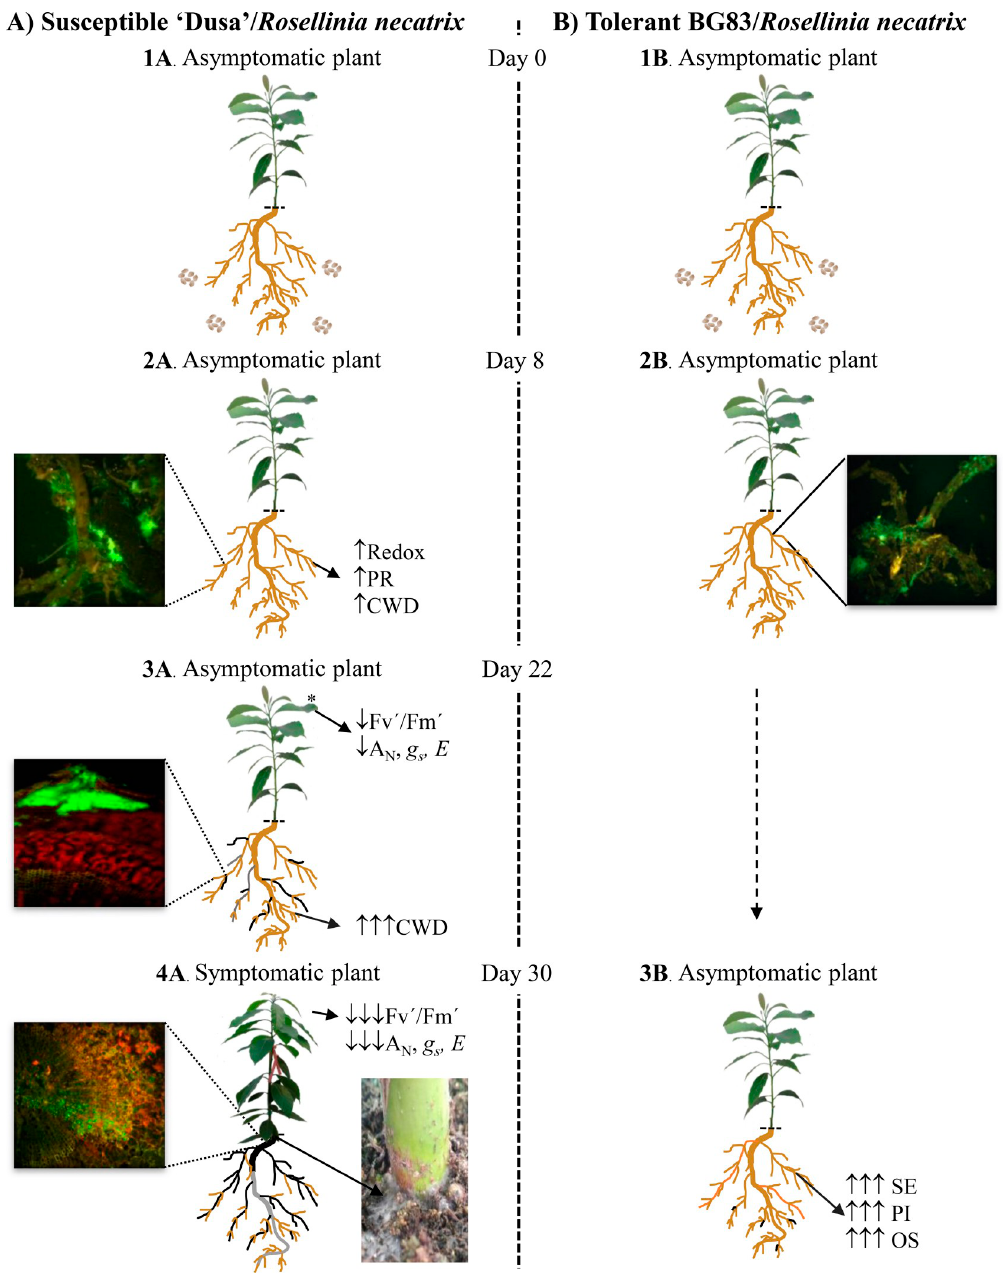
Fig 6. Comparative model of Rosellinia necatrix infection on susceptible ‘ Dusa ’ (A) and Tolerant BG83 genotypes (B) . 1A . Inoculation of asymptomatic ‘Dusa´plant with wheat grains infected with R . necatrix . 2A . 8 days post inoculation. Visualization of R . necatrix derivative strain CH53- gfp mycelia colonizing the root surface of avocado plantlets without aerial symptoms. The green fluorescent emitted from R . necatrix - gfp was visualized using a fluorescence microscope. Upregulation of genes mainly related to oxidoreduction activity (Redox), cell wall degradation (CWD) as well as potential genes involved in defence to P . cinnamomi (PR) was observed. 3A . 22 days post inoculation. The image shows a radial section of susceptible roots infected with R . necatrix - gfp ; penetration and proliferation of R . necatrix mycelia through the root cortex was observed by Confocal Laser Scanning Microscopy (CLSM) concomitant with a decrease in leaf photochemistry (Fv´/Fm´) and gas exchange parameters ( A N , gs , E ). Expression of genes related with cell wall degradation enzymes (CWD) mainly, chitin related enzymes, become more relevant. 4A . 30 days post inoculation, mild-wilting symptoms of the leaves start to appear in susceptible genotype. CLSM images of radial sections of the roots revealed a profuse invasion of R . necatrix , collapsing vascular vessels. 1B . Inoculation of asymptomatic BG83 plant with wheat grains infected with R . necatrix . 2B . 8 days post inoculation. Visualization of R . necatrix derivative strain CH53- gfp mycelia colonizing the root surface of avocado